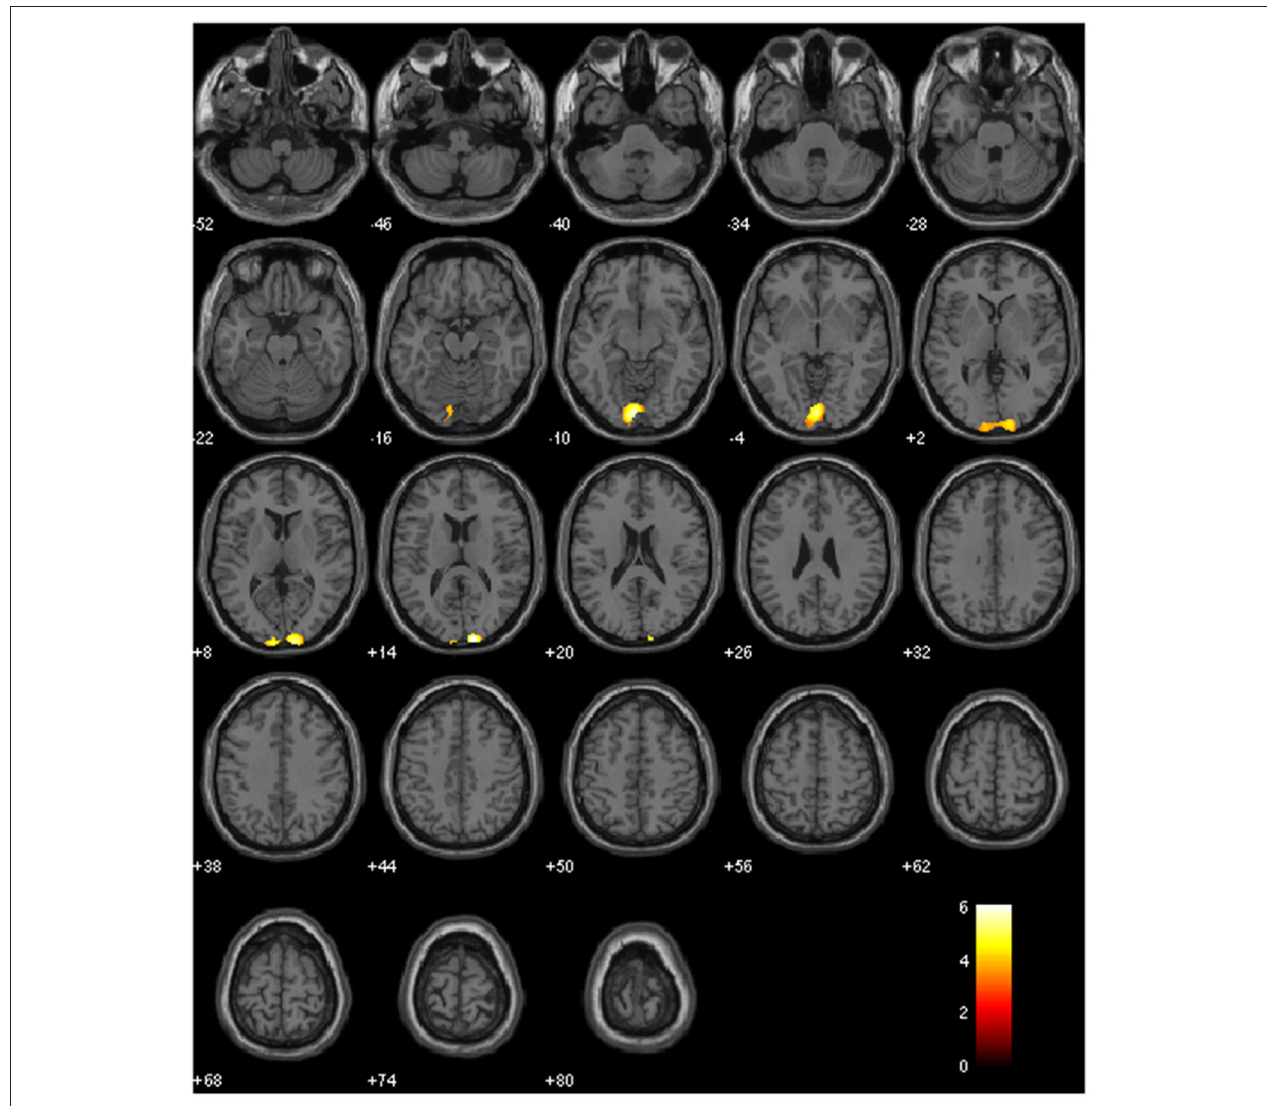
analogs revealed activations in bilateral cuneus and left lingual gyrus, The statistical significance refers to p < 0.001 (uncorrected) at voxel level, p < 0.05 at cluster level (FWE corrected).